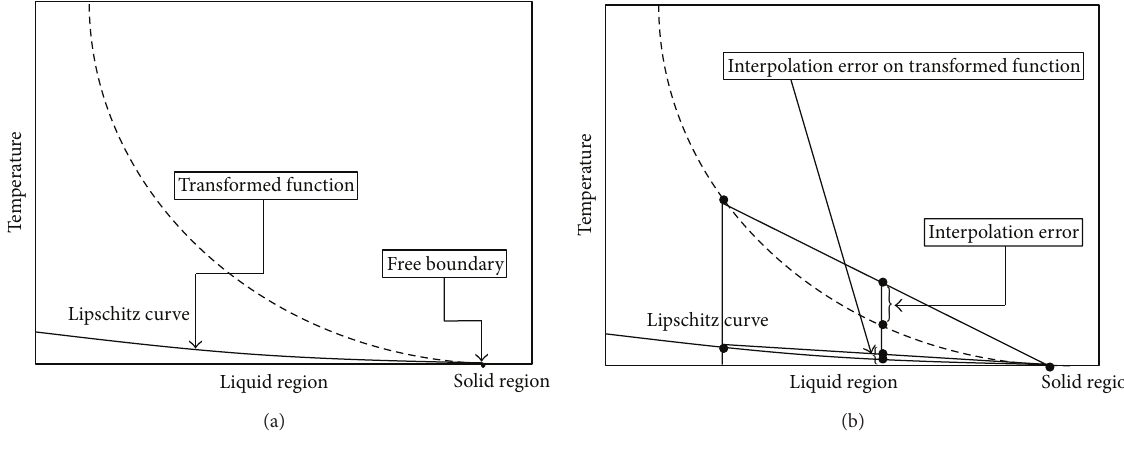
Figure 1: Log-transformation from 𝑢(𝑥,𝑡) to 𝑤(𝑥,𝑡)